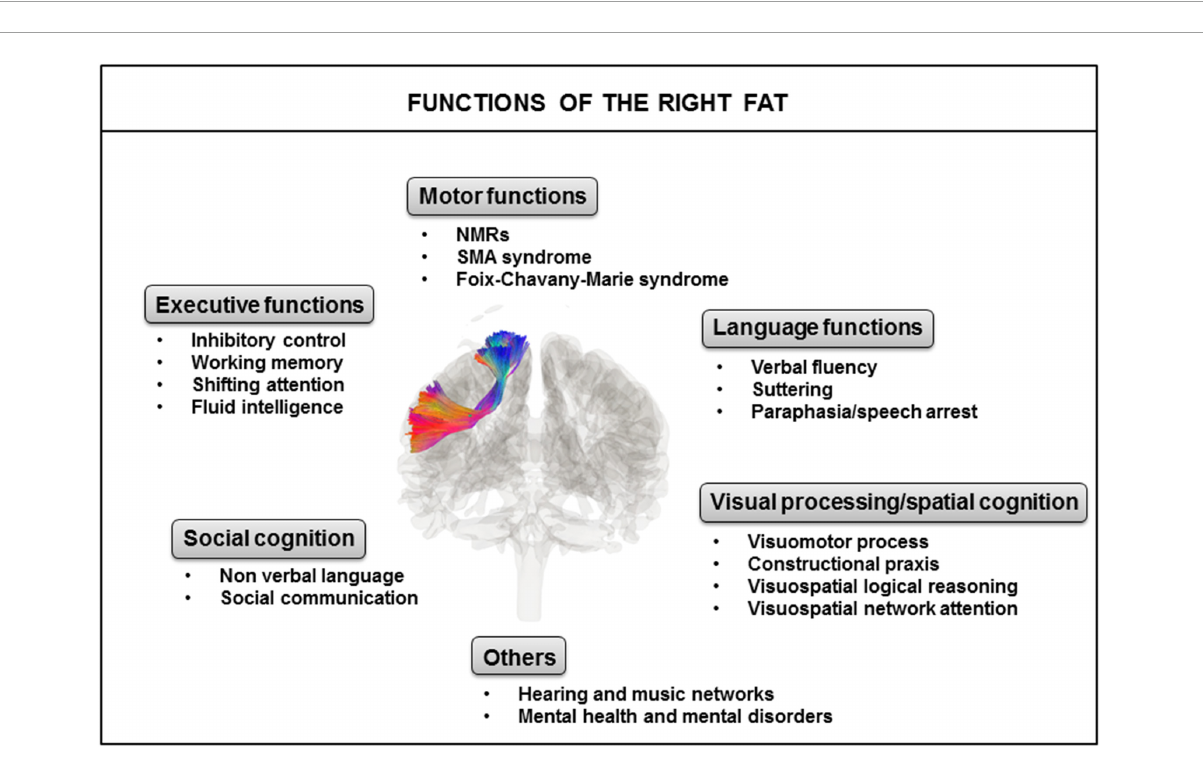
FIGURE3 Identified major functions of the right FAT. FAT, frontal aslant tract; NMRs, negative motor responses; SMA, supplementary motor area.